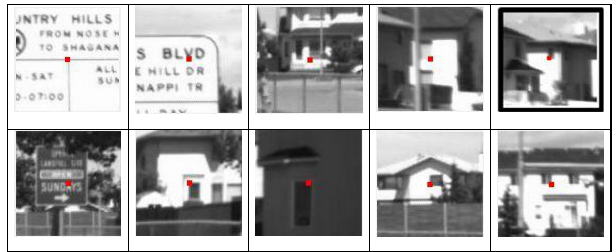
Figure 12. Matching results of type 1 dataset.